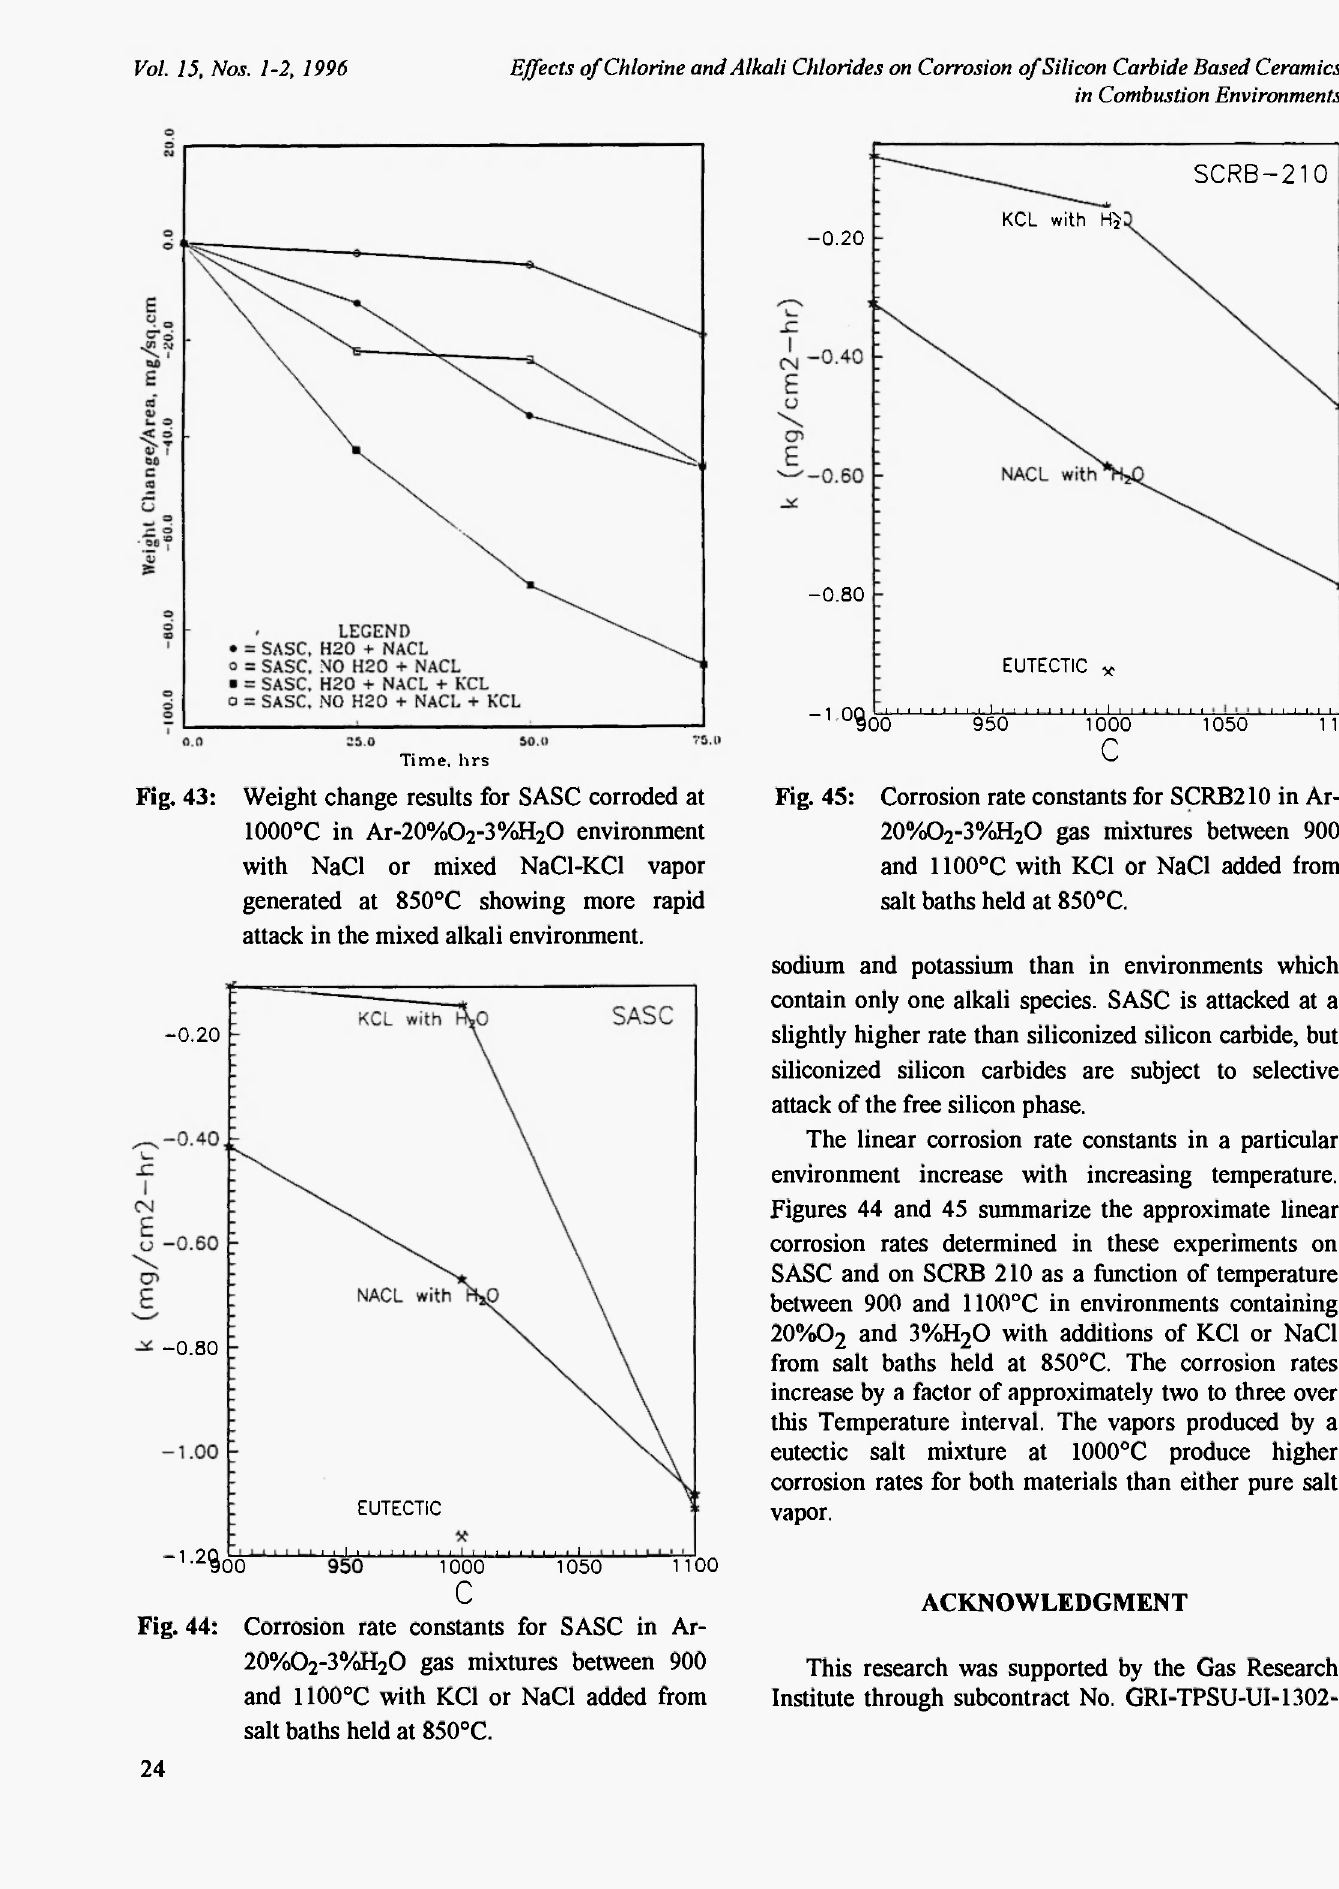
Fig. 44: Corrosion rate constants for SASC in Ar- 20%0 2 -3%H 2 0 gas mixtures between 900 and 1100°C with KCl or NaCl added from salt baths held at 850°C. 24